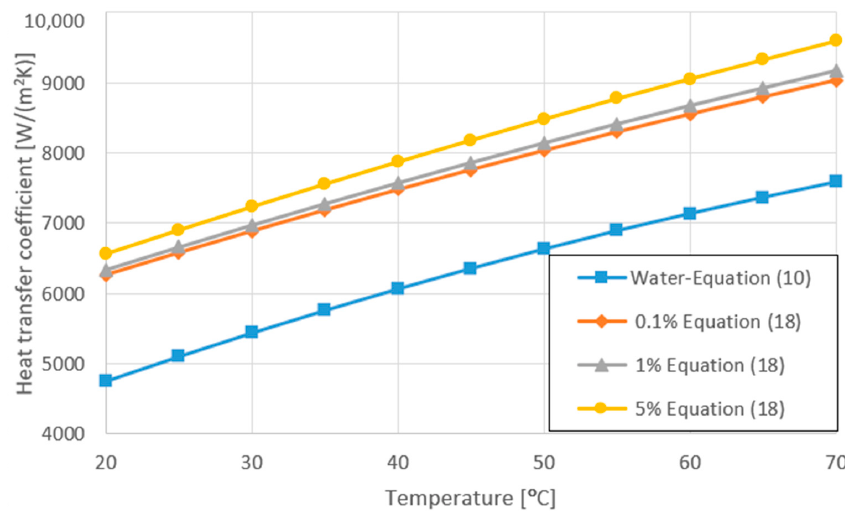
Figure 20, the influence of NPC on HTC for the tested mass concentration range 0.1% (cid:3407) 𝜑 ≤ 5% is negligible for the given temperature. (cid:3040) Figure 19. Variation of heat transfer coefficient for water-Al 2 O 3 nanofluids.